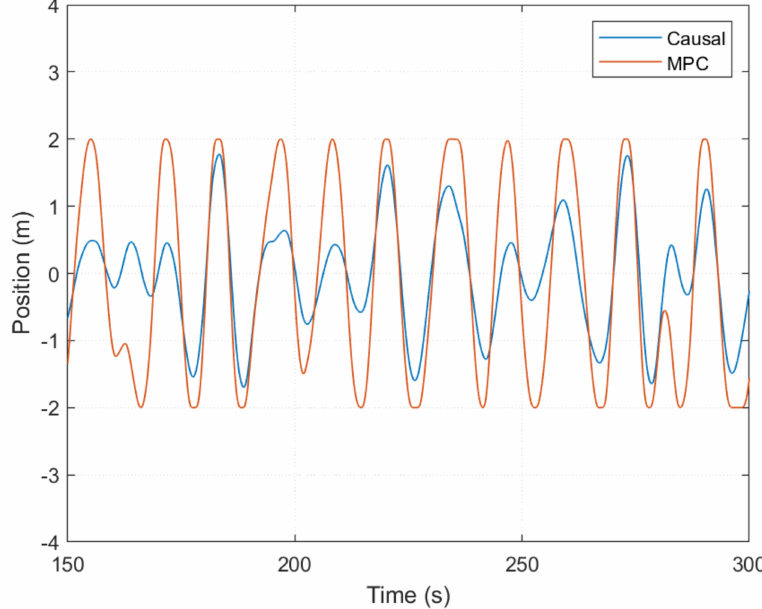
Figure 13. Comparison of position response using causal control vs. MPC for an input wave with Hs = 1.0 m, Tp = 15